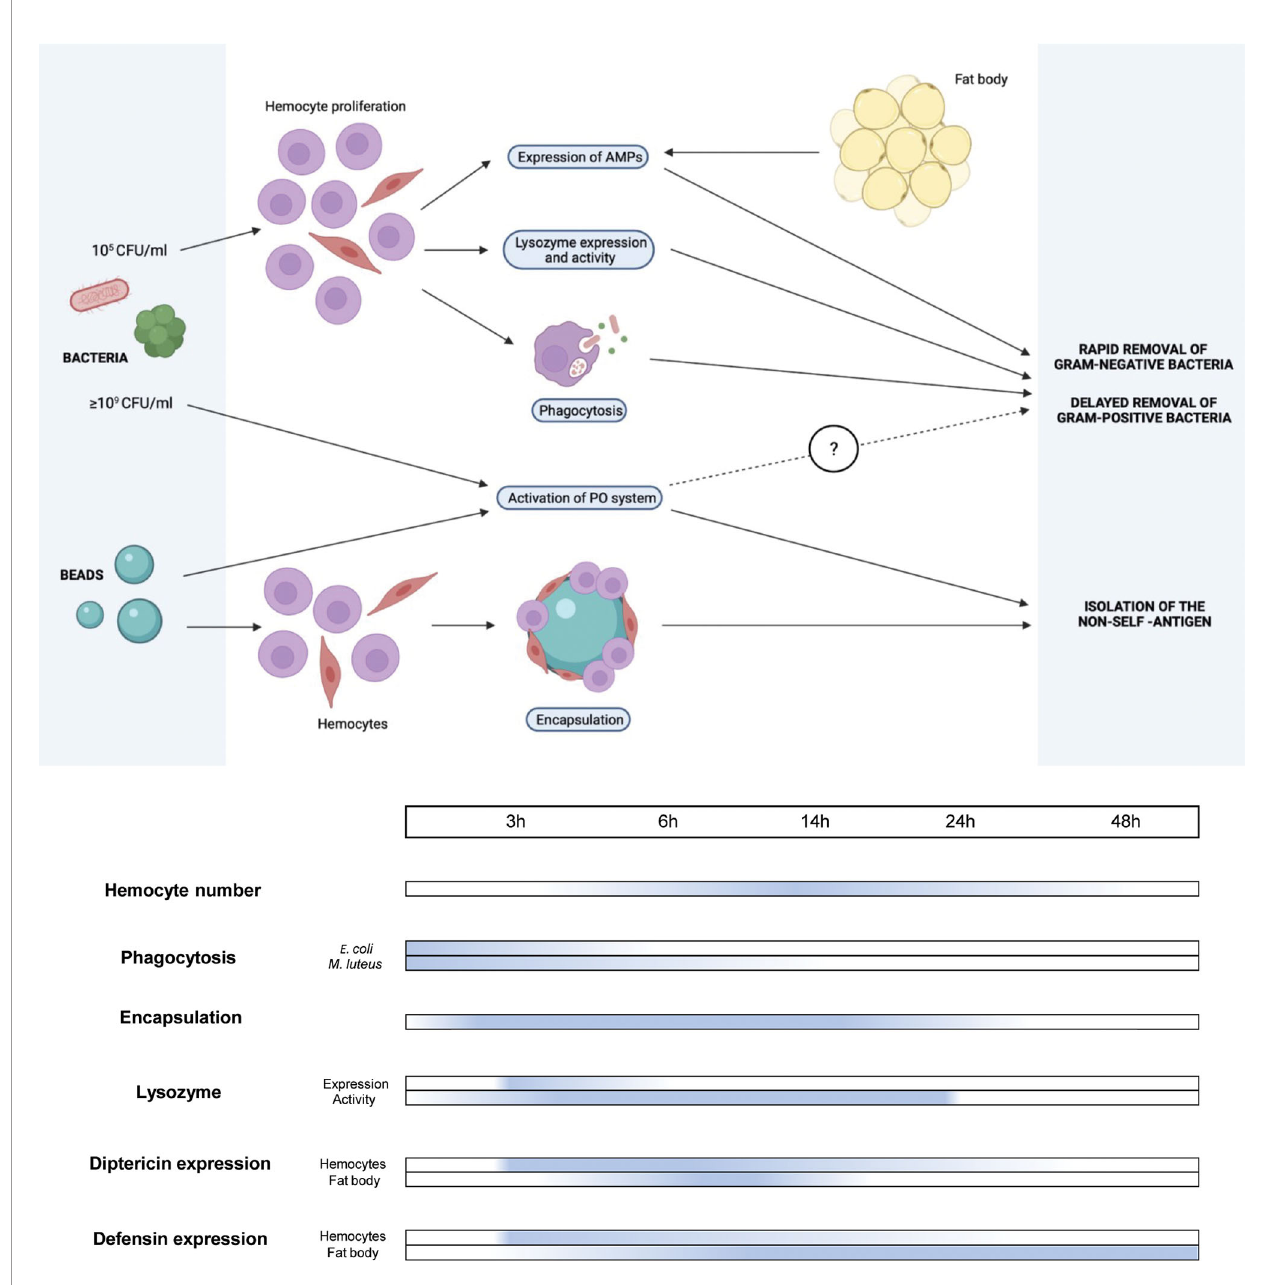
FIGURE 8 | Schematic representation of cellular and humoral responses in H. illucens larvae and activation